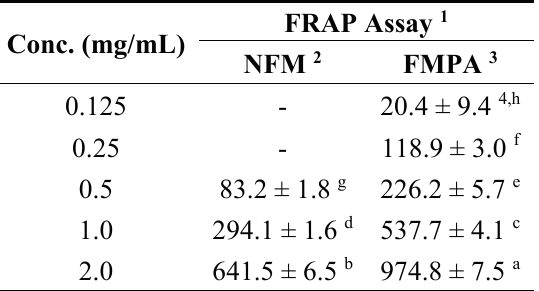
Table 3. Ferric-reducing antioxidative capacity of Magnolia denudata extract (70% ethanol) fermented by P. acidilactici KCCM